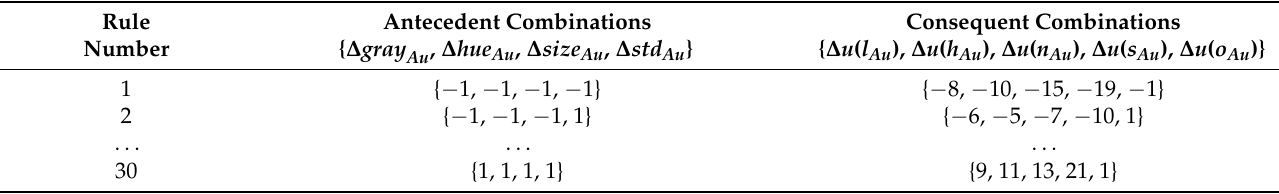
Table 8. Rule base of reagent compensation for gold rougher flotation.